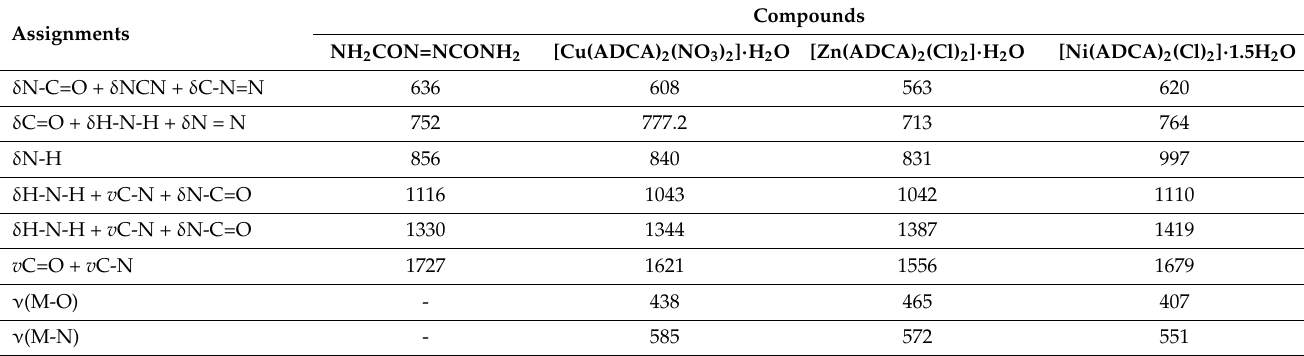
Table 2. Vibrational assignment of important IR bands of the azodicarbonamide ligand and its metal